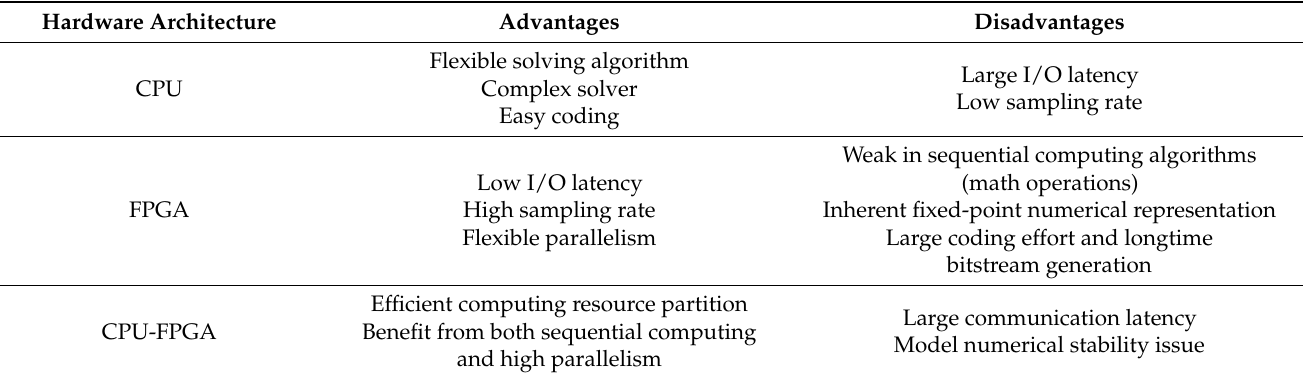
Table 1. Evaluation of different hardware